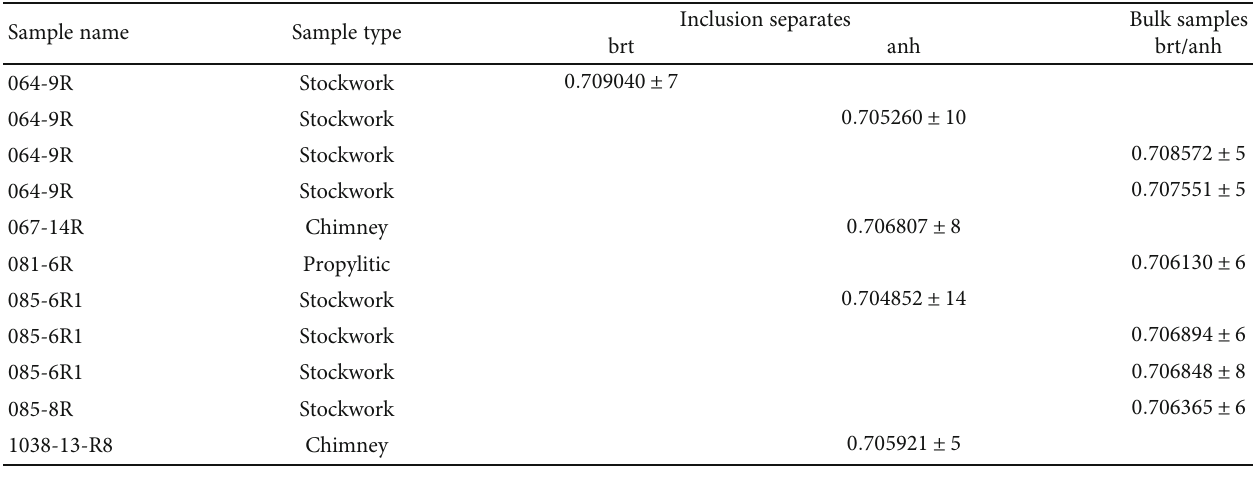
Table 3: 87 Sr/ 86 Sr values of mineral separates used in conjunction with fl uid inclusion studies and adjacent bulk rock from stockwork samples. brt: barite; anh: